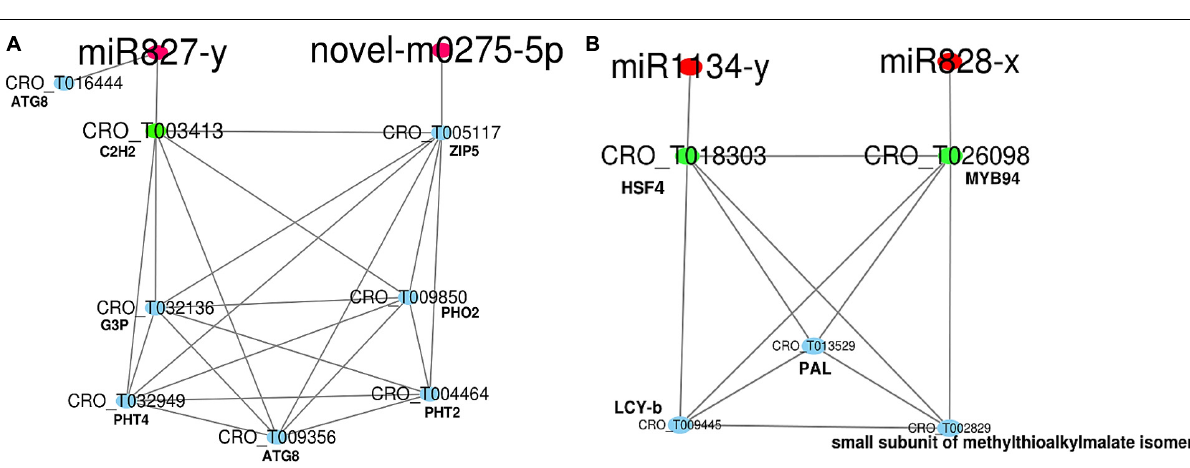
FIGURE 5 | The network of miRNA in the regulation of nutrient and secondary metabolism. The red nodes are miRNAs. The green nodes are transcription factors (TFs). The blue nodes are genes. (A) and (B) The nutrient and secondary related regulatory networks, respectively. The red nodes are miRNAs. The green nodes are TFs. The blue nodes are